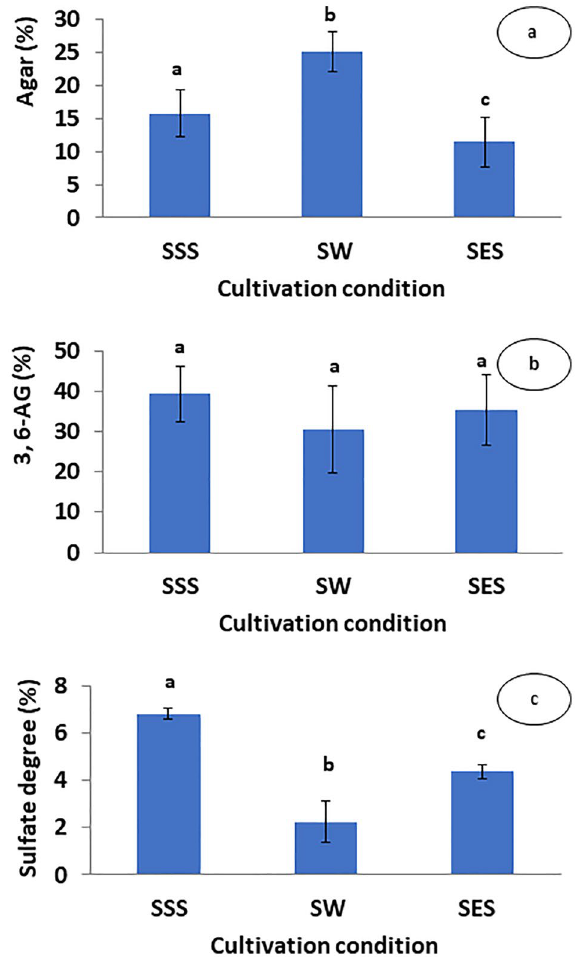
Figure 5. ( a ) Agar (%), ( b ) 3,6-anhydrogalactose content (3,6-AG; %), and ( c ) Sulfate degree (%) of Gracilaria gracilis expressed as average ± standard deviation (SD). Sulfur starved seawater (SSS), seawater (SW), and sulfur enriched seawater (SES). Sulfate concentrations [SO 4 2− ] of the treatments were 2.5 mM, 27 mM and 50 mM for SSS, SW, and SES, respectively; (n =